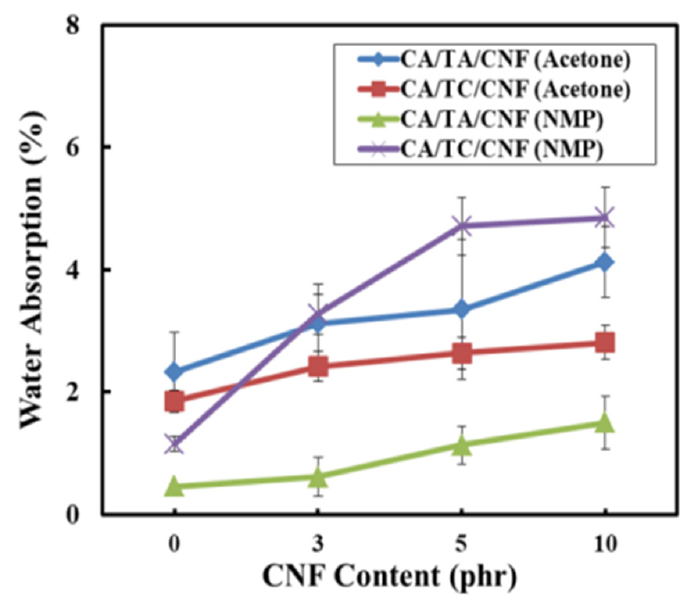
Figure 6. Water absorption of CA/TC/CNF and CA/TA/CNF with different CNF content prepared in both acetone and NMP solvent.